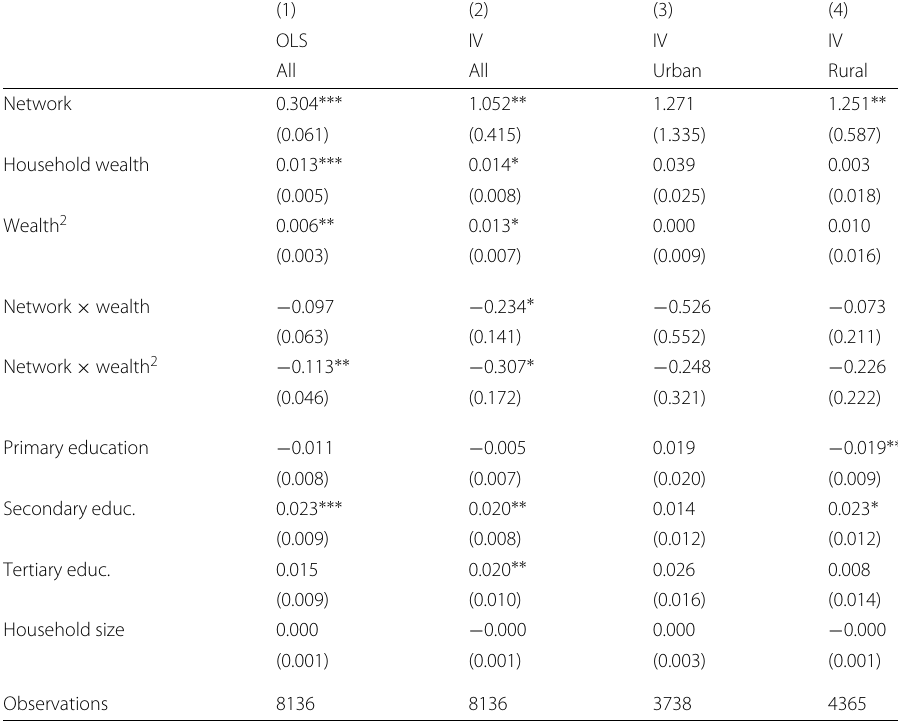
Table 12 Individual determinants of the emigration